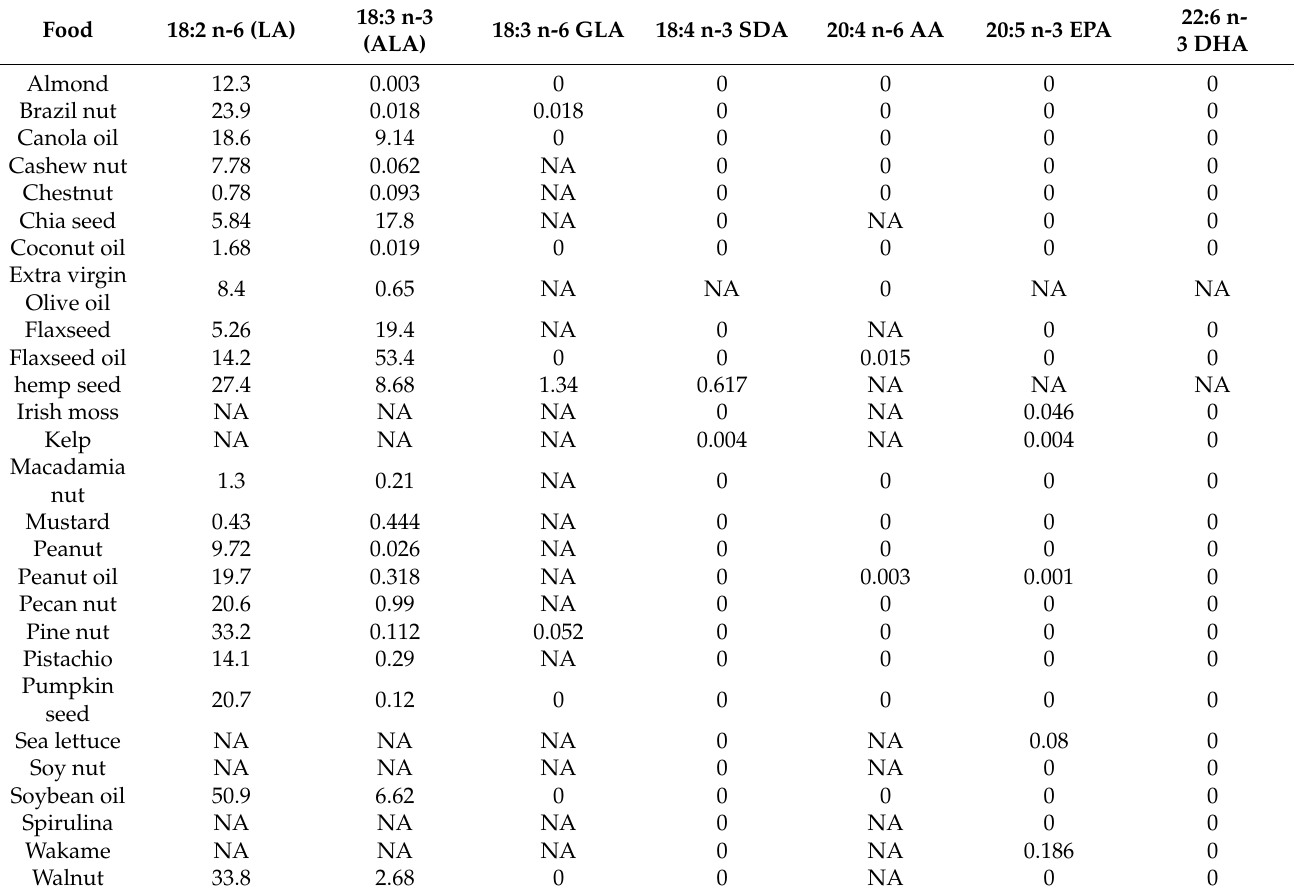
Table 1. Concentrations of EFAs in selected plant foods and oils (g per 100 g) 1